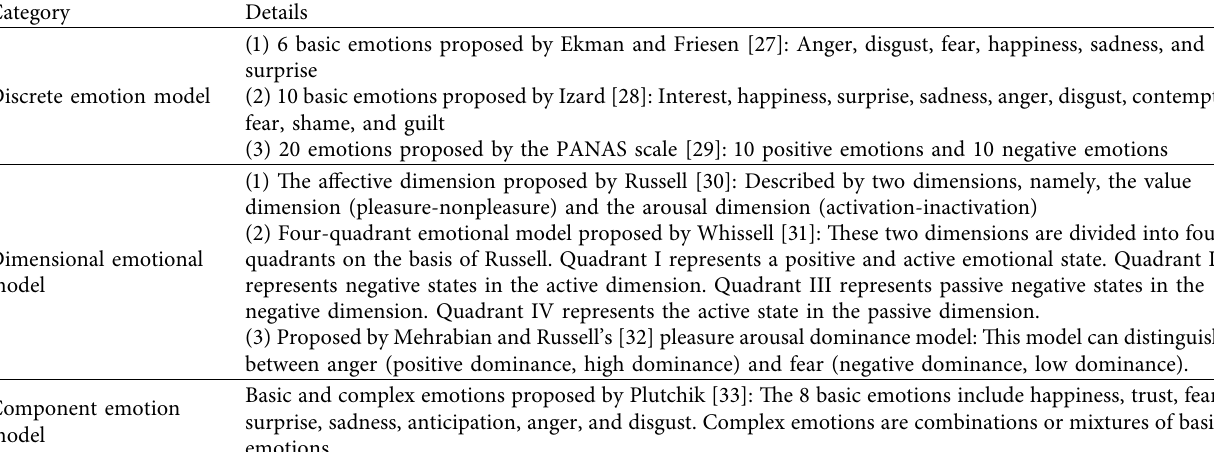
Table 1: Introduction to emotion